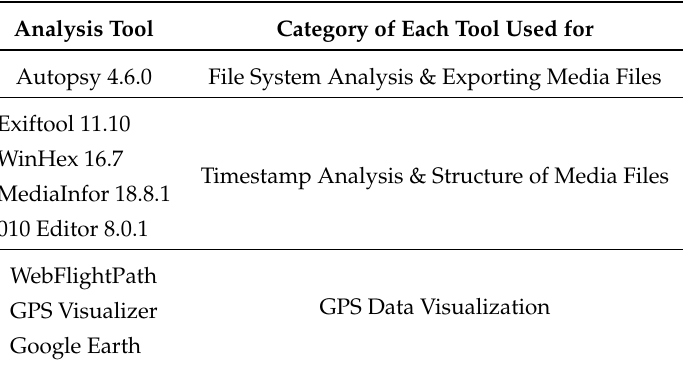
Table 1. The structure of analysis tools